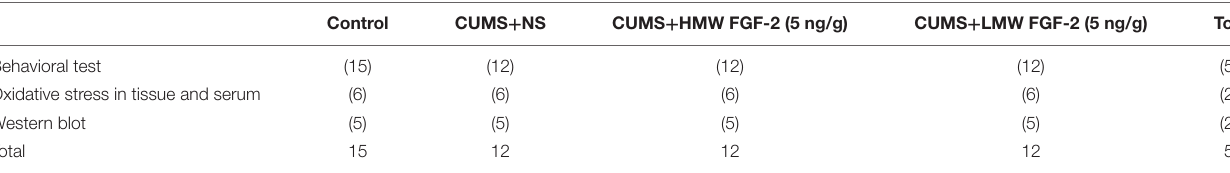
TABLE 1 | The number of mice in different groups and various testing experiments.